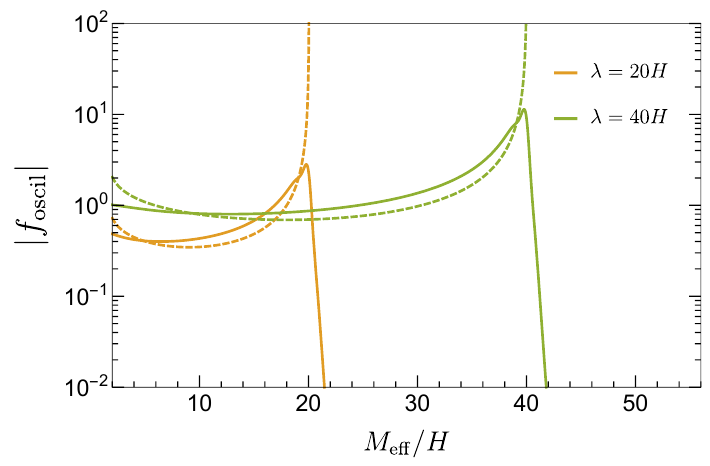
Figure 2. Comparison of | f oscil | as a function of M eff using stationary phase (dashed) and the full analytic form (solid) for two different values of the chemical potential λ = 20 H (yellow) and λ = 40 H (green), at c = 0 . 5 for α/ Λ = 0 . 1 λ . The parametric dependence matches for µ < λ as expected with a difference of an O (1) factor. This mismatch can be attributed to contributions from other vertices which we did not consider in the stationary phase approximation above just for simplicity. Note the full calculation also smooths out the naive divergence in the stationary phase estimate as µ ≈ λ since for such µ the approximation made in our stationary phase estimate breaks